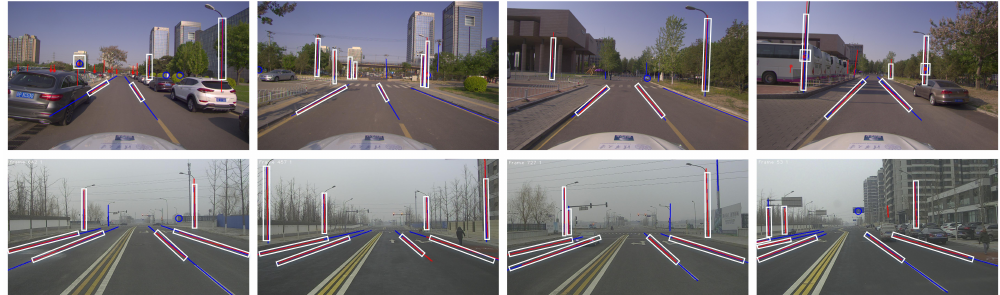
Figure 15. The map matching results. The top four images are from scenario 1, and the bottom 4 are from scenario 2. Recognized features are denoted in blue, and landmarks re-projected according to the result of localization are denoted in red; White boxes indicate successfully matched